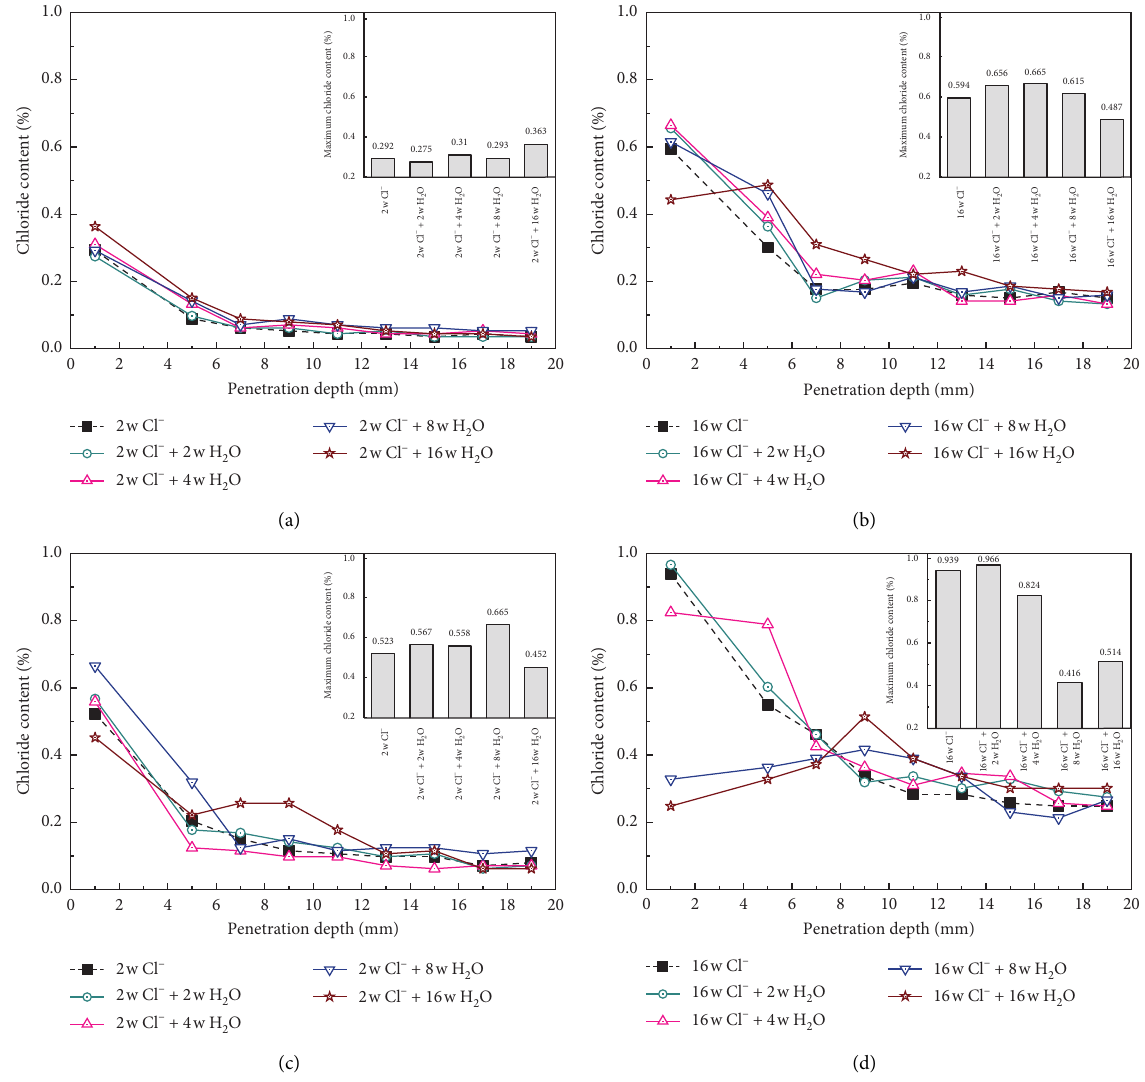
Figure 10: Chloride content curves of concrete after chloride attack and water convection time. (a) After 2-week chloride attack (w/c � 0.4), (b) after 16-week chloride attack (w/c � 0.4), (c) after 2-week chloride attack (w/c � 0.6), and (d) after 16-week chloride attack (w/c � 0.6). “2w Cl − ” represents that chloride content was immediately determined after 2-week chloride attack (control group); “2w Cl − +16w H 2 O” presents that the concrete was first subjected to the chloride attack for 2 weeks and then the opposite surface connected with water for 16